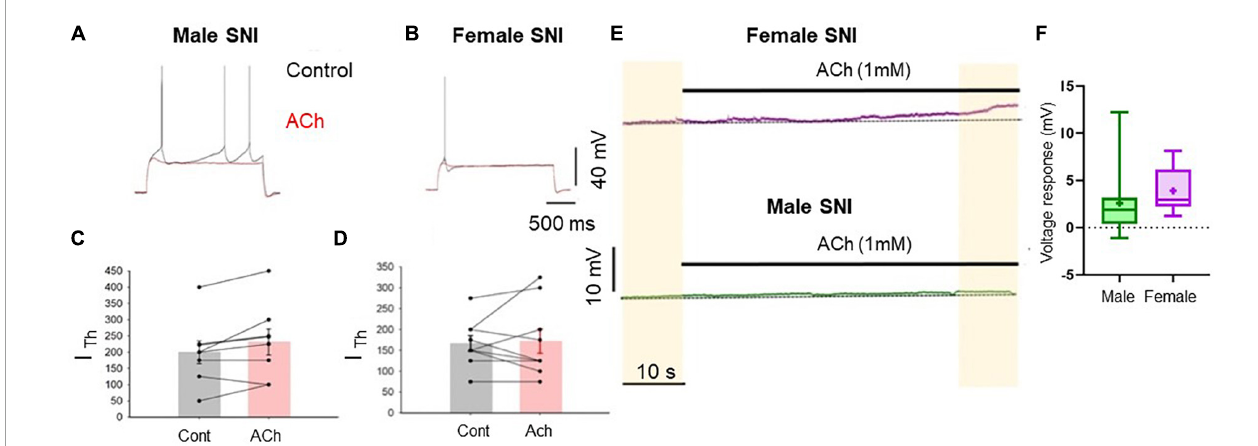
FIGURE3 Cholinergic excitatory modulation of PLC pyramidal cells is abolished in SNI animals. Voltage traces recorded from L5 pyramidal neurons in acute slices from male (A) and female (B) SNI rats (1 week after peripheral injury) in the presence of blockers of fast synaptic transmission (50 µ M picrotoxin and 2.5 mM kynurenic acid). Responses to 2-s-long injection of near-threshold depolarizing current in control conditions (black) and after 1 mM ACh (red). Resting potential was ∼ –75 mV. ACh failed to increase cellular excitability. In males, ACh significantly decreased neuronal excitability, producing an increase in rheobase current from 200 ± 35.4 to 231.3 ± 40.3 pA (C) . In females, ACh did not significantly impact the input/output curve or the rheobase current (D) . (E) Voltage responses to ACh application in continuous recordings in slice from a female (top trace) and a male (bottom trace) rat at constant bias current injection. (F) Summary of the Ach-induced depolarization obtained in slices from SNI rats. The depolarization was 3.427 ± 0.25 mV in females and 0.554 ± 0.16 mV in males ( p = 0.0037 for males vs. females, Mann-Whitney test, n = 8 and 9 cells,